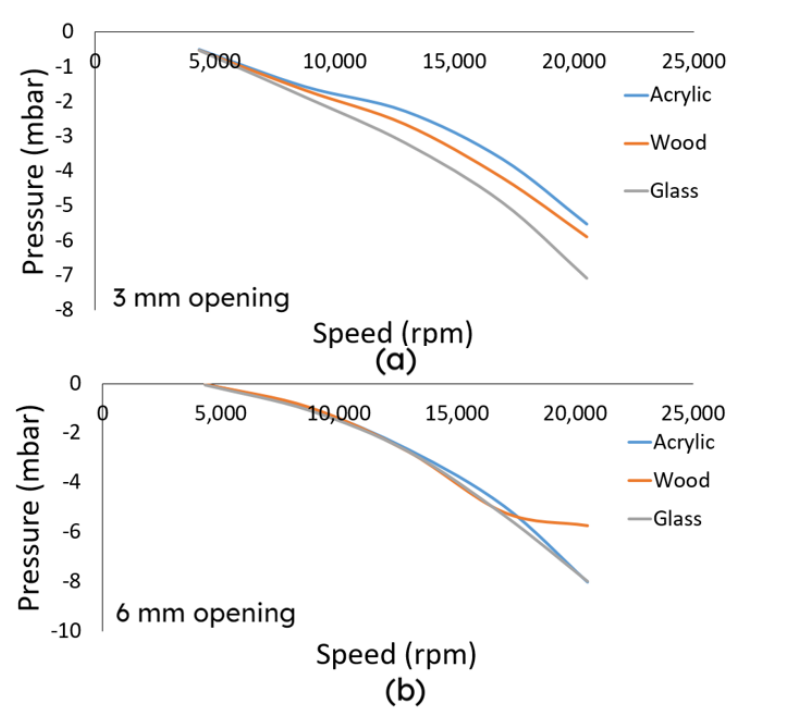
Figure 20. Variation of pressure with respect to speed on different surfaces by placing the pressure sensor near the central region of suction module with ( a ) 3 mm opening and ( b ) 6 mm